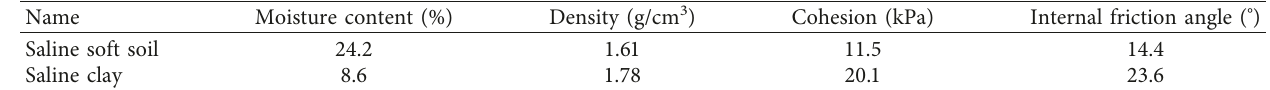
Figure 2: Typical bore diagram on-site and schematic section of proposed foundation schemes. (a) Saline soft soil. (b) Saline clay. (c) Schematic section of the proposed foundation schemes. Table 1: Main physical and mechanical indexes of model foundation